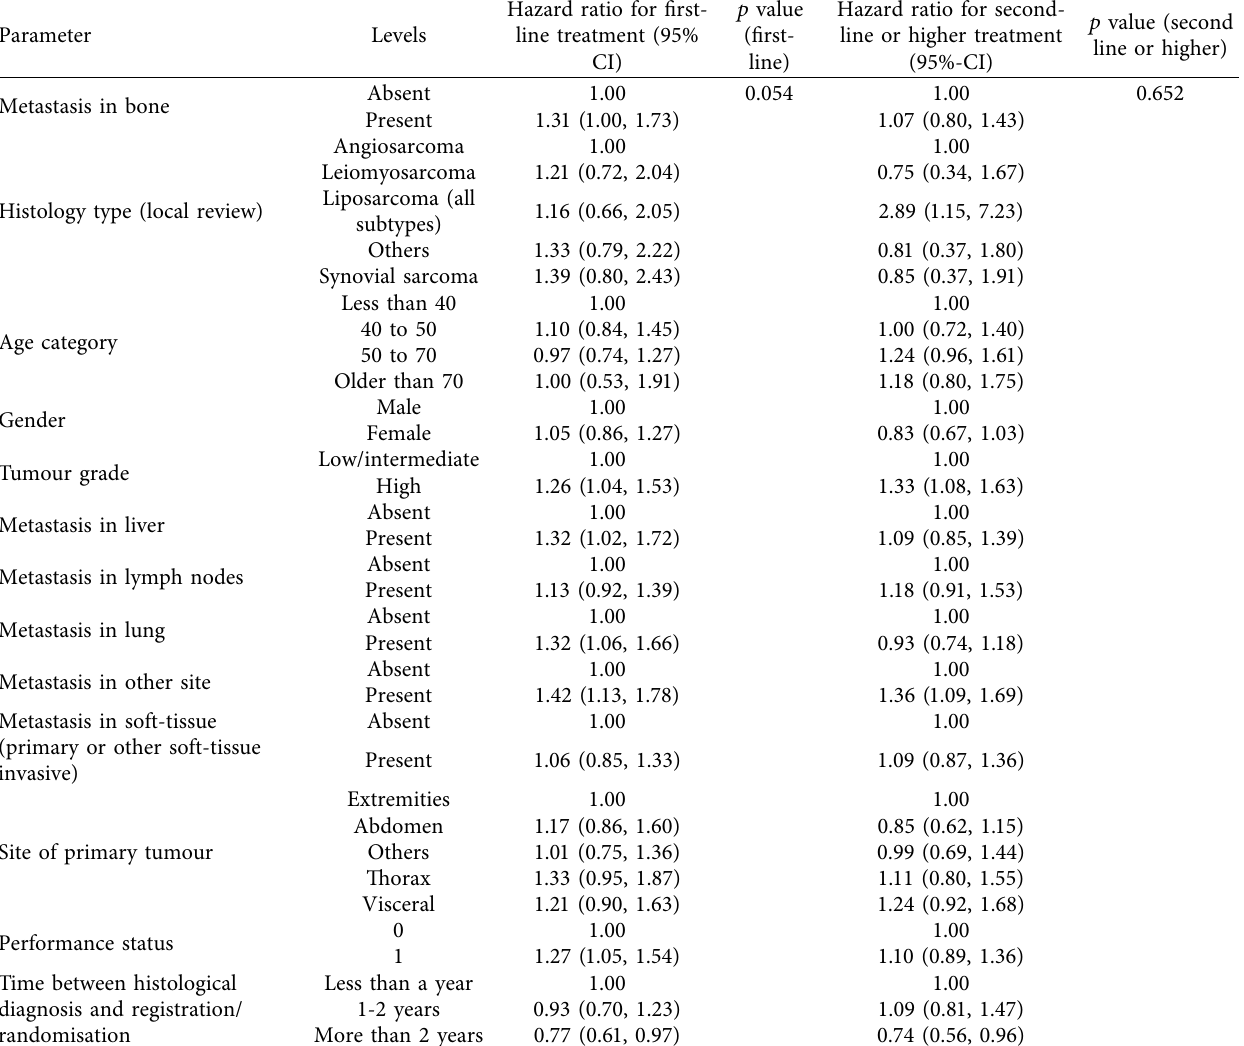
Table 4: Cox model for the adjusted effect of bone metastasis on PFS per line of treatment stratified by